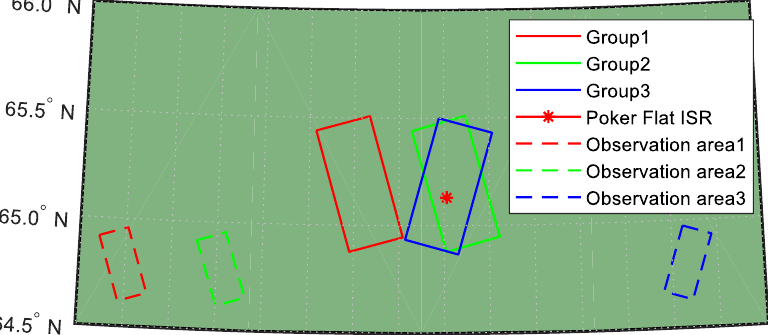
Figure 1. Position relationship of three ground tracks of PALSAR scenes and Poker Flat ISR. The red rectangle corresponds to the PALSAR scene of Group 1, while the green and the blue ones correspond to the measurement of Group 2 and Group 3, respectively. The position of Poker Flat ISR is shown as a red asterisk, while the observation area of each group is shown as a dashed rectangle in its corresponding color.